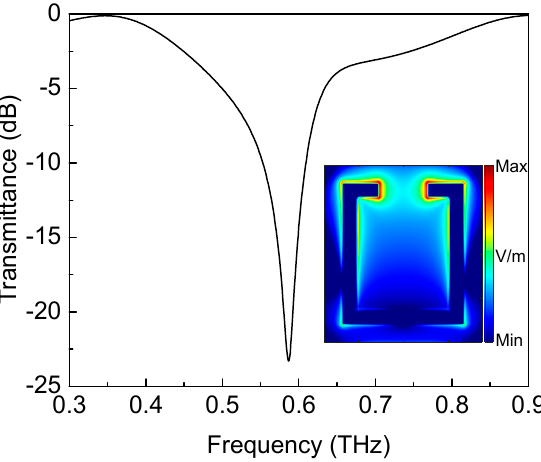
Figure 3. Simulated spectrum of PI-coated metamaterials. The insert presents the near-field distri- bution of the simulated SRR with the PI film at 0.588 THz.